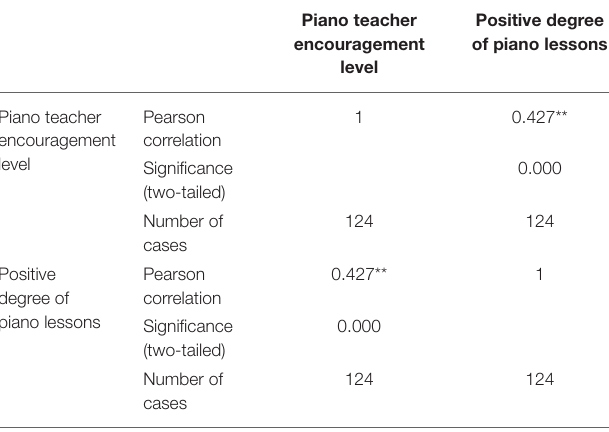
TABLE 3 | Correlation analysis between encouragement degree of teachers and piano learning activeness.